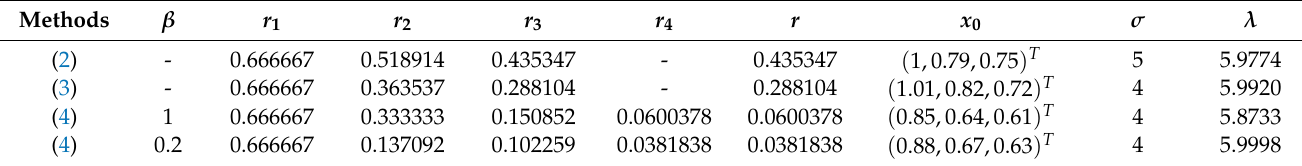
Table 3. Radii for Example 3.